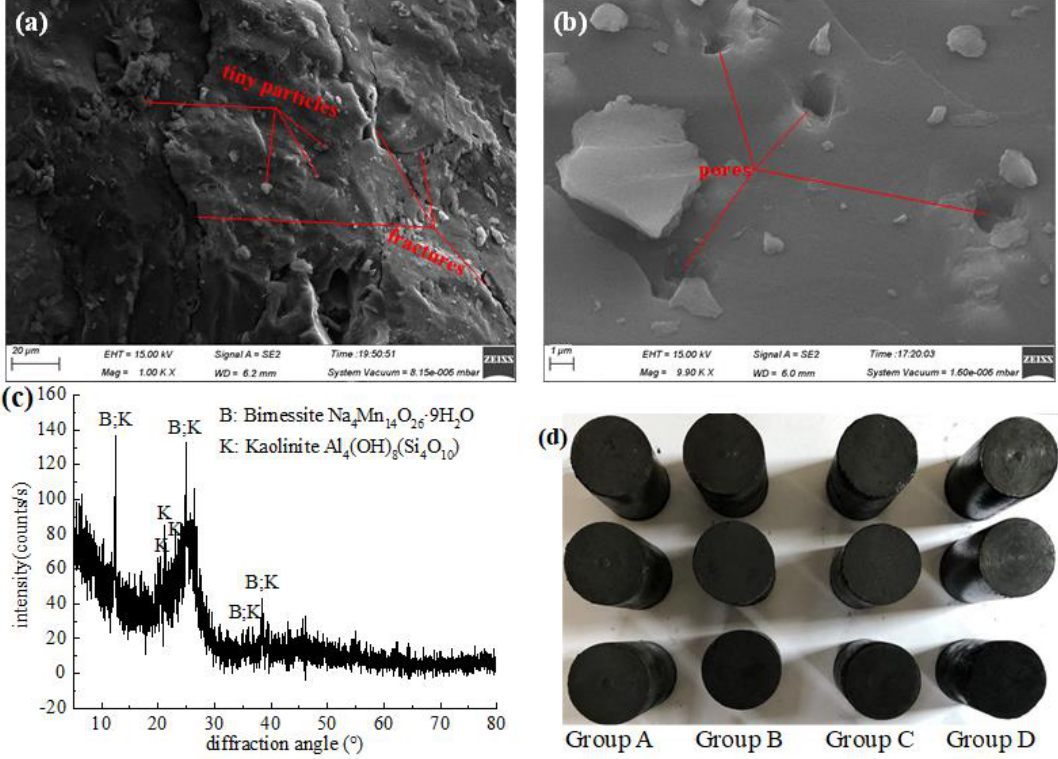
Figure 2. ( a , b ) Surface micromorphology of the pulverized coal; ( c ) X-ray di ff raction pattern of pulverized coal; ( d ) part of the briquette